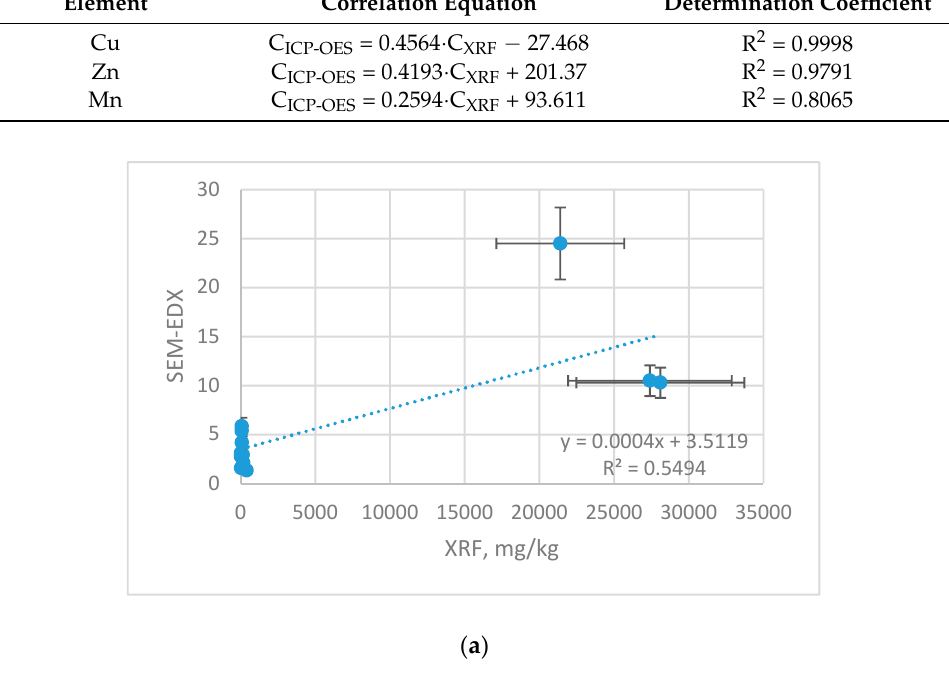
Table 5. Correlation equations for C ICP-OES = f(C XRF ), mg/kg. Element